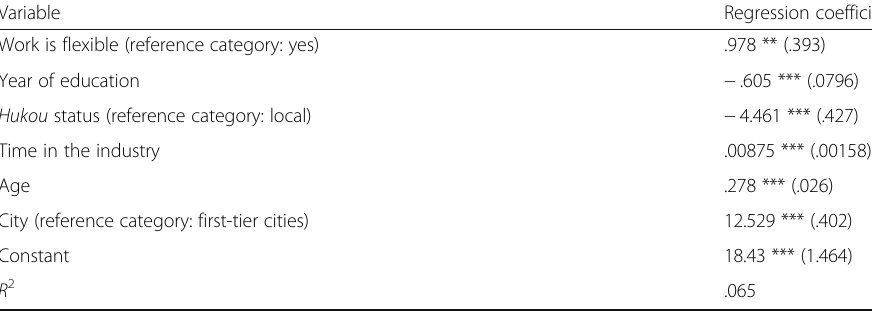
Table 5 Regression results: part-time drivers N = 7121 Variable Regression coefficient Work is flexible (reference category: yes) .978 ** (.393) Year of education − .605 *** (.0796) Hukou status (reference category: local) − 4.461 *** (.427) Time in the industry .00875 *** (.00158) Age .278 *** (.026) City (reference category: first-tier